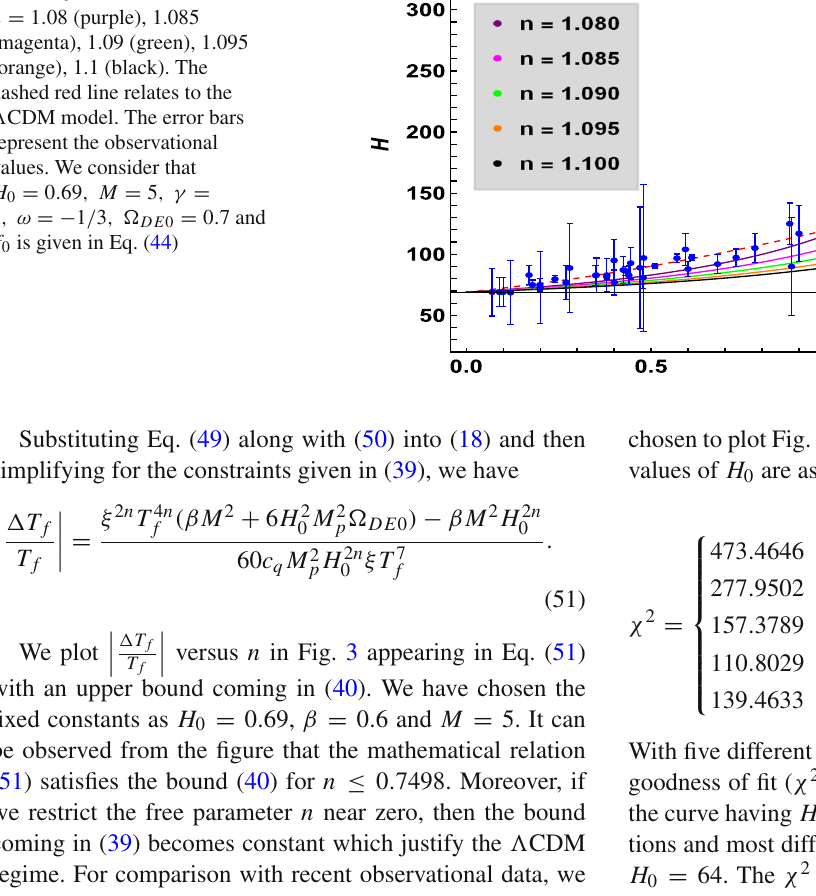
Fig. 2 The evolution of the Hubble parameter H against redshift z for different values of n = 1 . 08 (purple), 1.085 (magenta), 1.09 (green), 1.095 (orange), 1.1 (black). The dashed red line relates to the (cid:2) CDM model. The error bars represent the observational values. We consider that H 0 = 0 . 69 , M = 5 , γ = 1 , ω = − 1 / 3 , (cid:15) DE 0 = 0 . 7 and f 0 is given in Eq. (44)